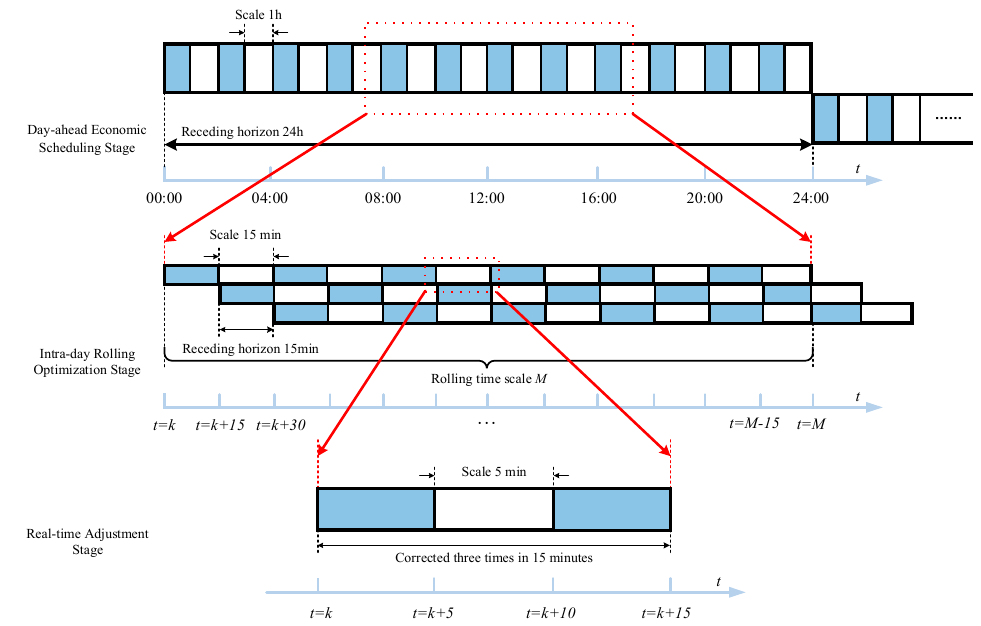
Figure 2. The relationship between the three scheduling stages.